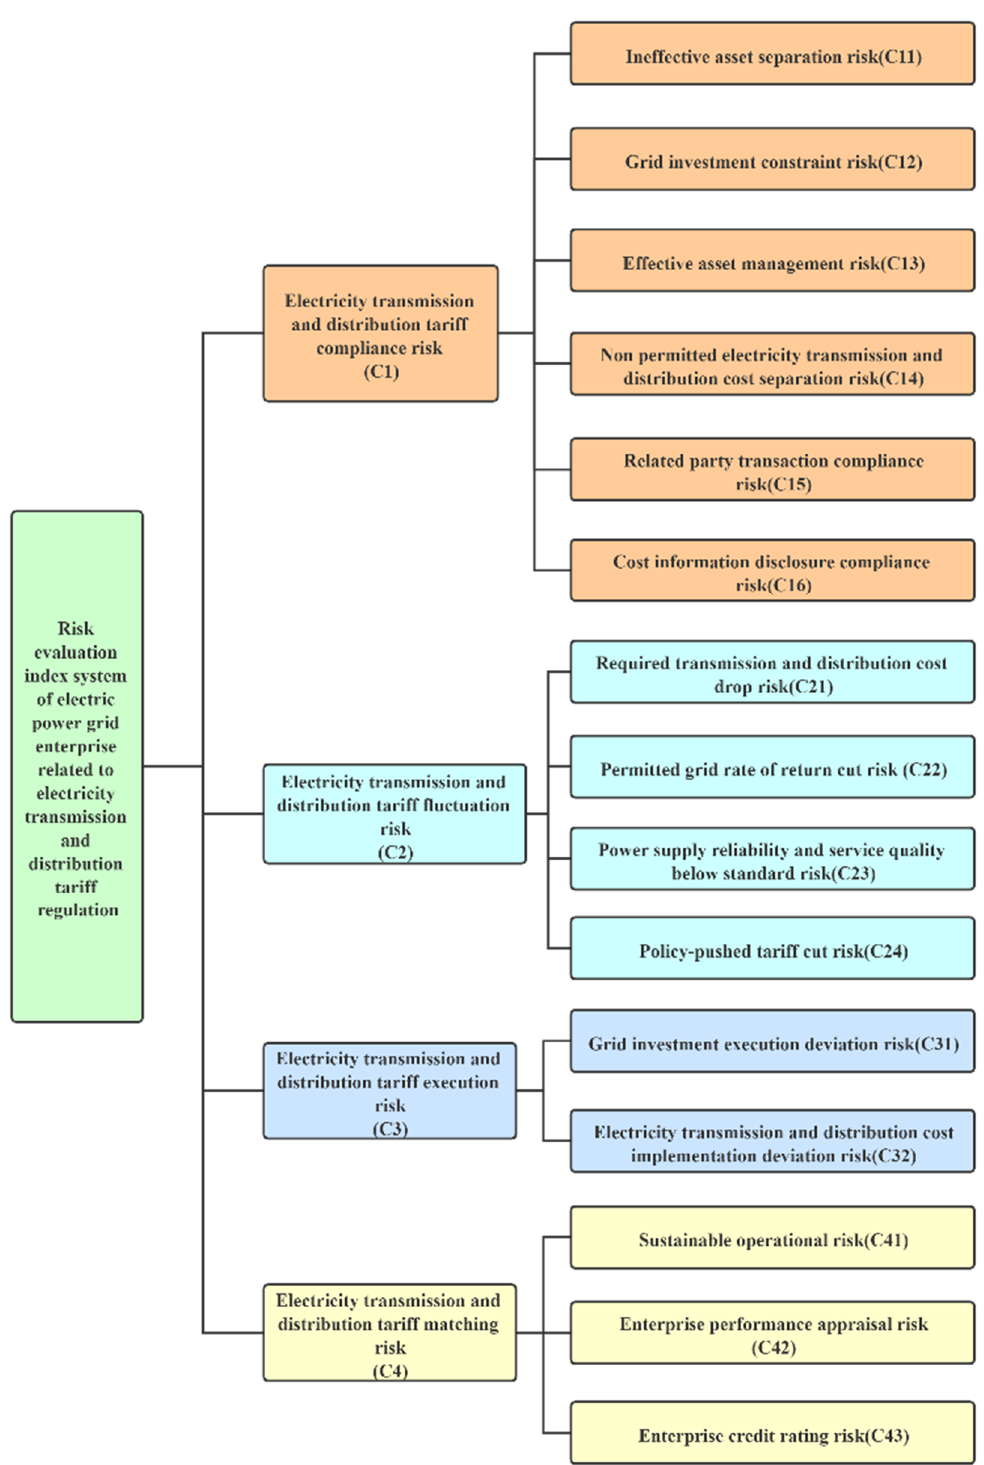
Figure 1. Risk evaluation index system of electric power grid enterprise related to electricity transmission and distribution tariff regulation.